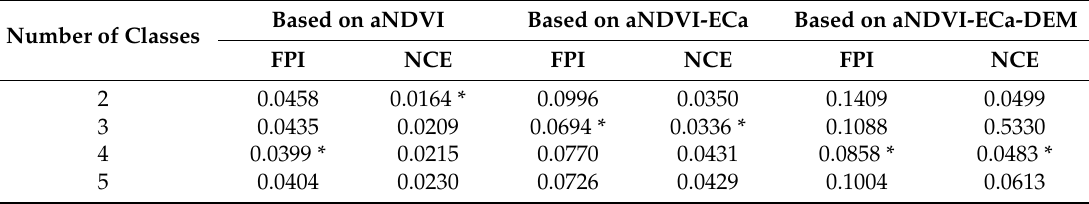
Table 4. Values of the fuzziness performance index (FPI) and the normalized classification entropy (NCE) for different number of classes after clustering using the Management Zone Analyst (MZA) software.